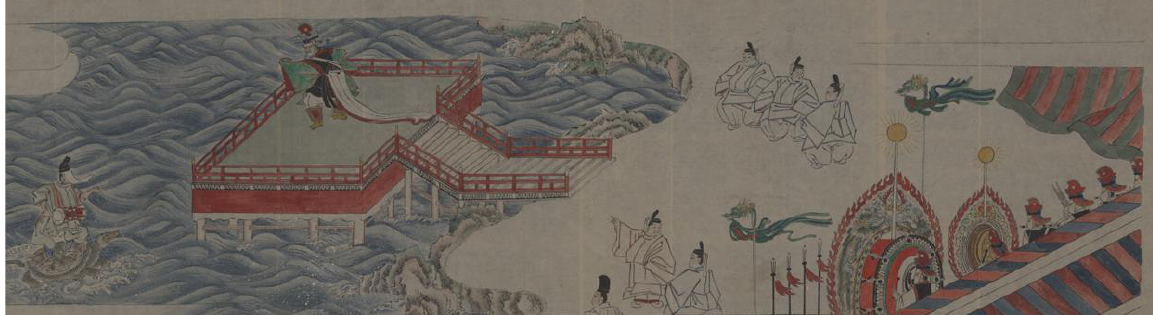
Figure 6. Konda [or Honda ] Hachiman engi 誉田八幡縁起 (The story of Honda/Konda Hachiman, mid-18th – 19th centuries). Staatsbibliothek zu Berlin (Berlin State Library, Berlin). Courtesy of the Hachiman Project, University of Heidelberg. At https://kjc-sv038.kjc.uni-heidelberg.de/hachiman/#O4639.3/, accessed on 15 June 2022.